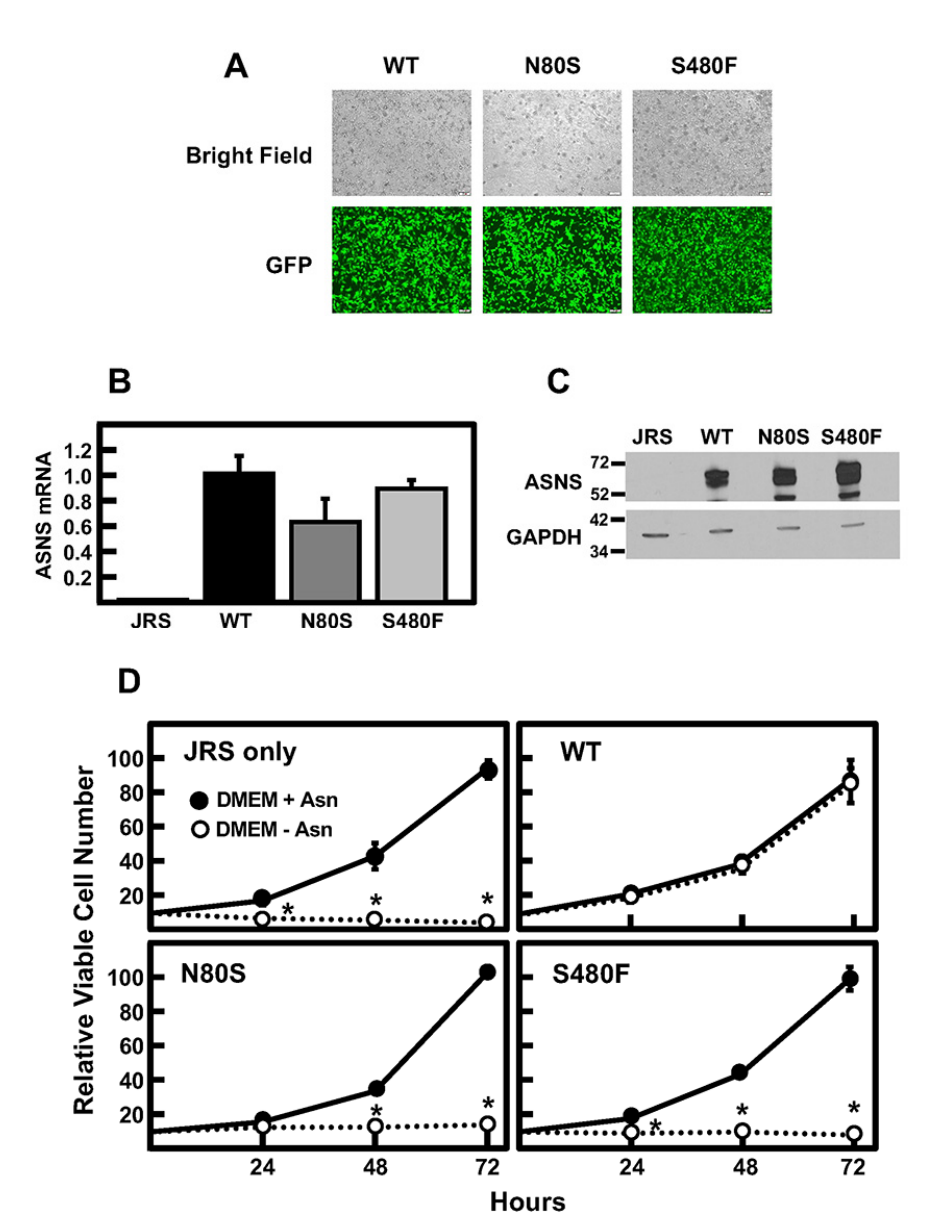
Figure 6. ASNS cDNA constructs encoding WT, N80S, and S480F were independently stably ex- pressed in an ASNS-null background JRS cell line. ( A ) Co-expression of GFP with ASNS cDNA constructs permits evaluation of retroviral transduction efficiency in generation of the JRS model system. ASNS mRNA ( B ), as determined by qRT-PCR, and relative ASNS protein abundance ( C ) evaluated by immunoblotting for each of the generated JRS cell lines. ( D ) Cellular proliferation was determined by cell counting of the JRS cell lines in the presence or absence of Asn in the media for 0, 24, 48, and 72 h. The data are the averages ± standard deviations of three determinations, and an asterisk indicates that the DMEM—Asn value is statistically different from the Asn-containing condition with a p -value of ≤ 0.05.